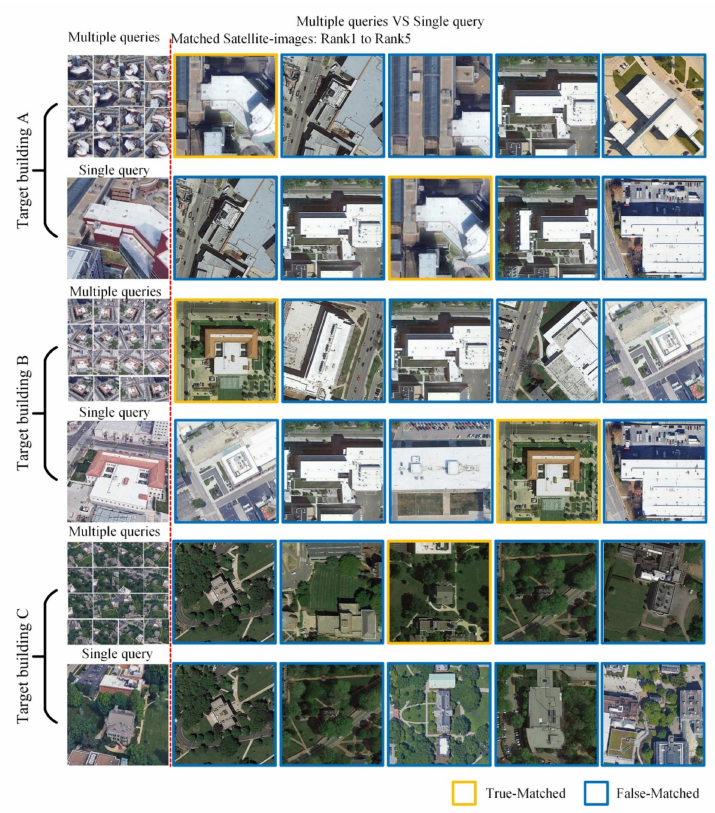
Figure 9. The matching results of multiple queries for UAV-to-satellite (the features of 54 UAV-view images are averaged as features of multiple